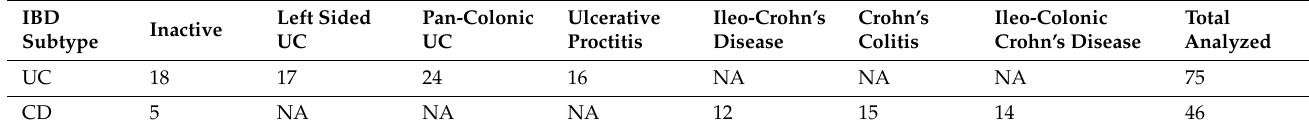
Table 2. Disease sub-types in collected biopsies. Summary of endoscopic analysis at the time biopsies were collected, based on 121 chart